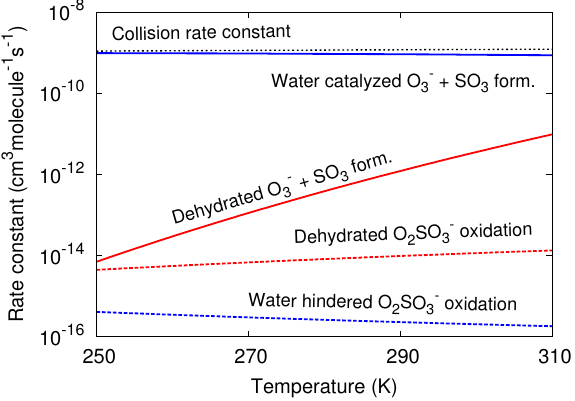
Fig. 4. Bimolecular rate constants of cluster decomposition mecha- nism and O 2 SO − oxidation in cm 3 molecule − 1 s − 1 as function of 3 temperature. For both the dehydrated and the monohydrated sys- tems, cluster breakup is favoured although much more so in the hy- drated systems. At standard conditions and 50% relative humidity, ca. 90% of O 2 SO − is monohydrated. The collision rate constant 3 with O 3 is indicated (50% relative humidity).